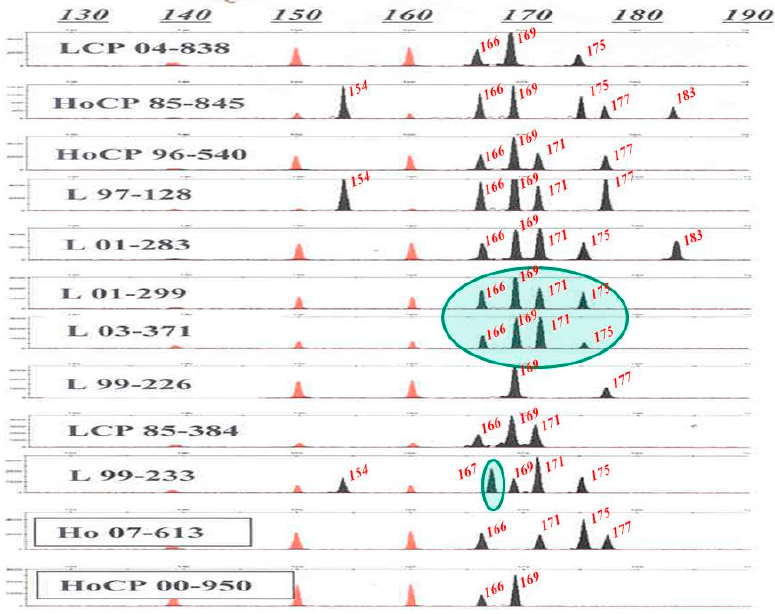
Figure 2. Capillary electrophoregrams of eight microsatellite (SSR) DNA fingerprints (filled in black color) from 12 Louisiana sugarcane cultivars, namely (from top), LCP 04-838, HoCP 85-845, HoCP 96-540, L 97-128, L 01-283, L 01-299, L 03-371, L 99-226, LCP 85-384, L 99-233, HoCP 07-613, and HoCP 00-950, and three DNA size markers, 139, 150, and 160 base pairs (filled in red color). The fingerprints of cultivars are amplified from the genomic DNA of leaf tissue through PCR primed by SMC336BS primer pair. The values shown on top are size marks and the values shown on left represent relative fluorescence intensity strength or the relative yield of amplified DNA fragment. The size of these eight SSR DNA fingerprints is 154, 166, 167, 169, 171, 175, 177, and 183 bp, respectively.